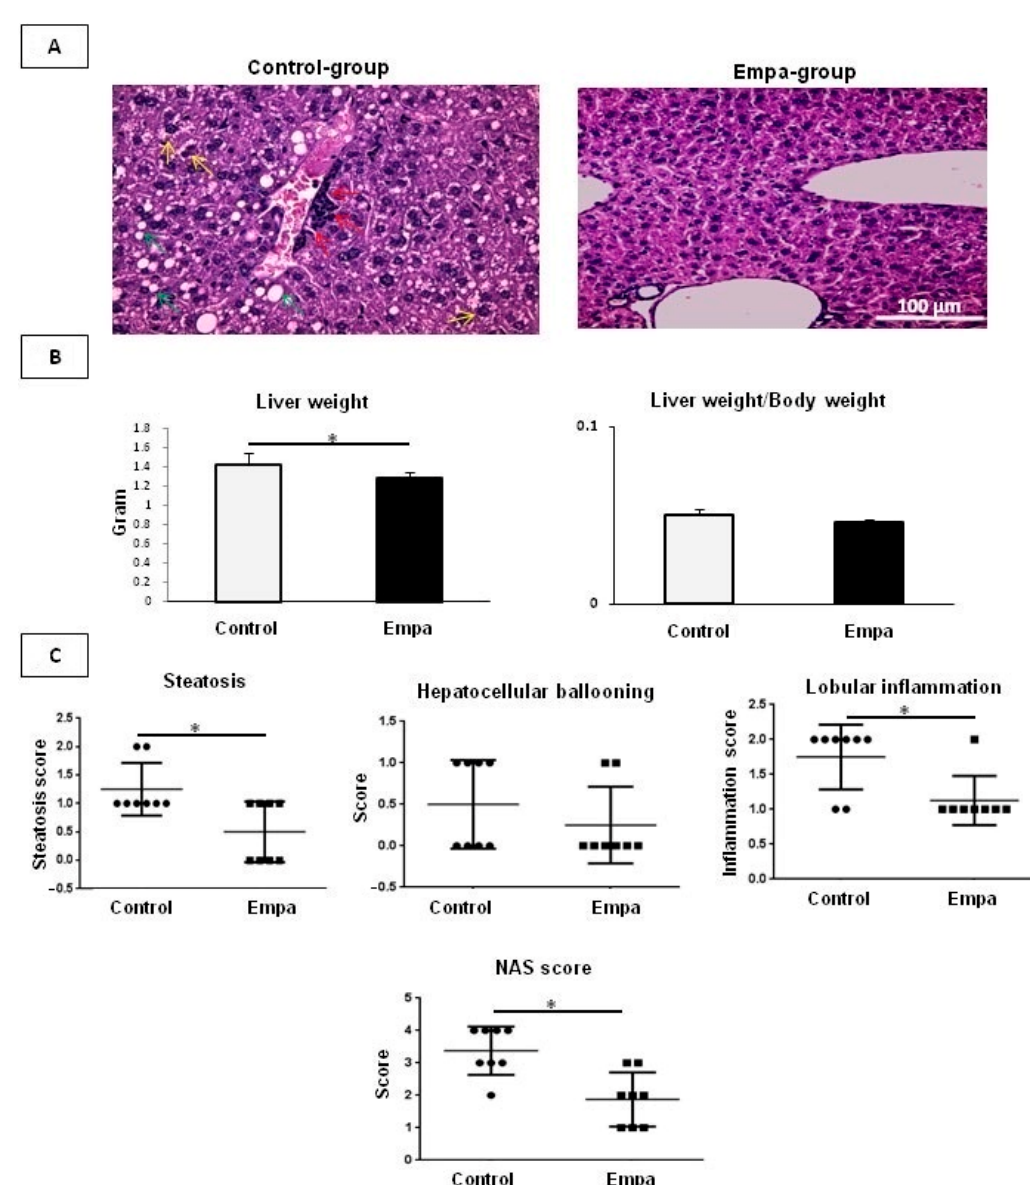
Figure 2. Histological assessment of NAFLD/NASH severity. ( A ) Representative images of H&E-stained slides of ApoE (-/-) mice after five weeks of empagliflozin/vehicle oral administration. Lobular inflammation, ballooning cells and cytoplasmic lipid droplets are shown by red, yellow and green arrows, respectively. ( B ) The liver weight and the ratio of liver weight to body weight. ( C ) Histological evaluation of steatosis, hepatocellular ballooning, lobular inflammation and NAS score. Data are shown as the mean ± SD (*: p < 0.05).